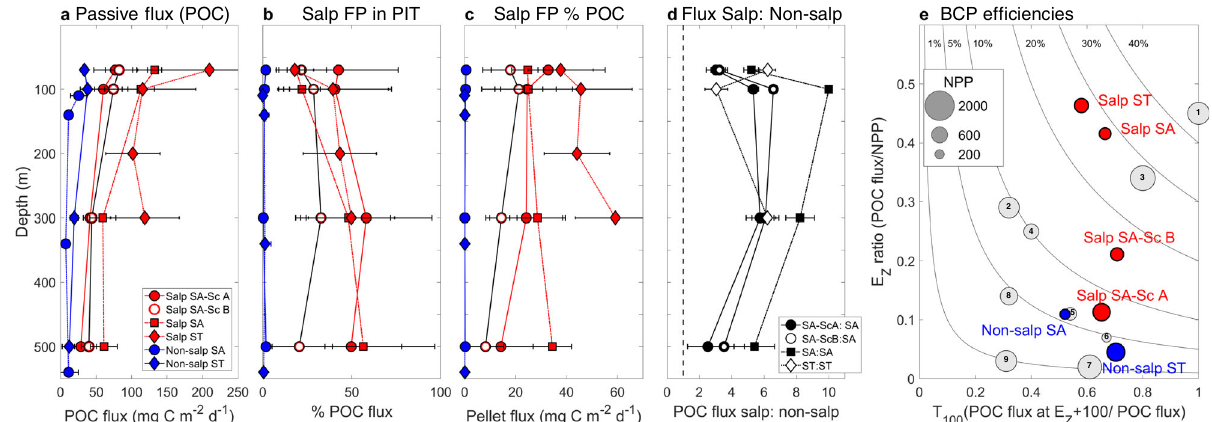
Fig.5|Patternsincarbonexport fl ux. Mean±stdof a export fl uxesofparticulate organic carbon (POC), b carbon fl ux due to recognizable salp fecal pellets (FP), c relative contribution of intact salp FP to POC fl ux. Colors and symbols for experimental cycles are denoted in the legend in ( a ). d Ratio of POC fl ux between Salp and non-salplocations, with three comparisons for SAwaters, and one for ST waters.Dotedlineindicatesaratioof1. e E Z ratio,theratioofPOC fl ux:netprimary production(NPP),asafunctionofT 100 (POC fl uxatE Z +100m/POC fl ux).Numbers indicate locations compared in ref. 3: 1 — North Atlantic Bloom Experiment (NABE)